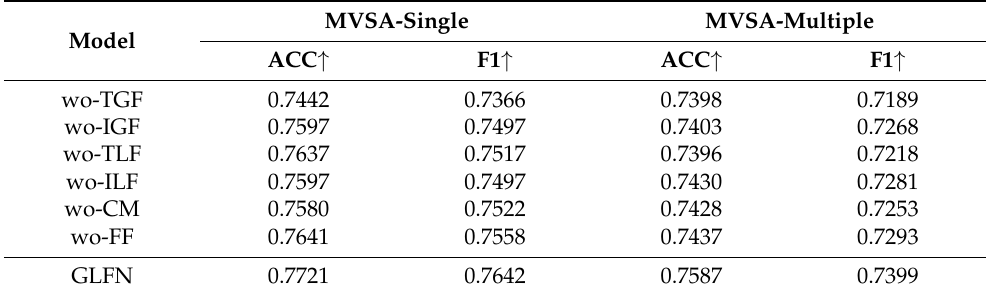
Table 2. Ablation study results of the GLFN model ( ↑ denotes the value is larger, the performance of model is